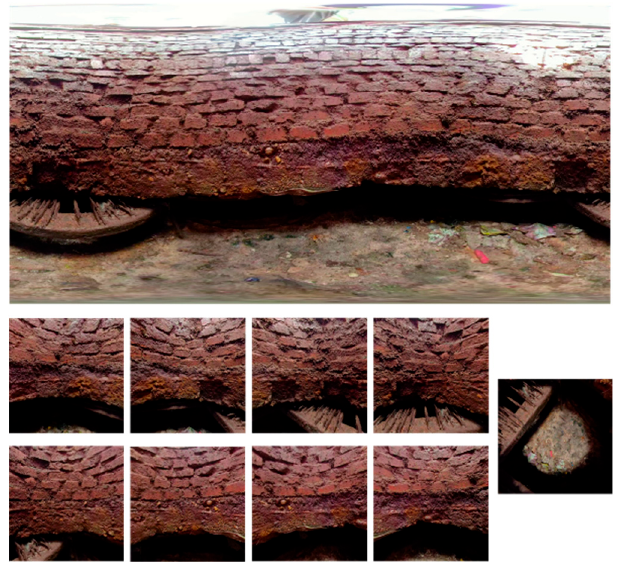
Figure 4. Reprojection result of a panorama.